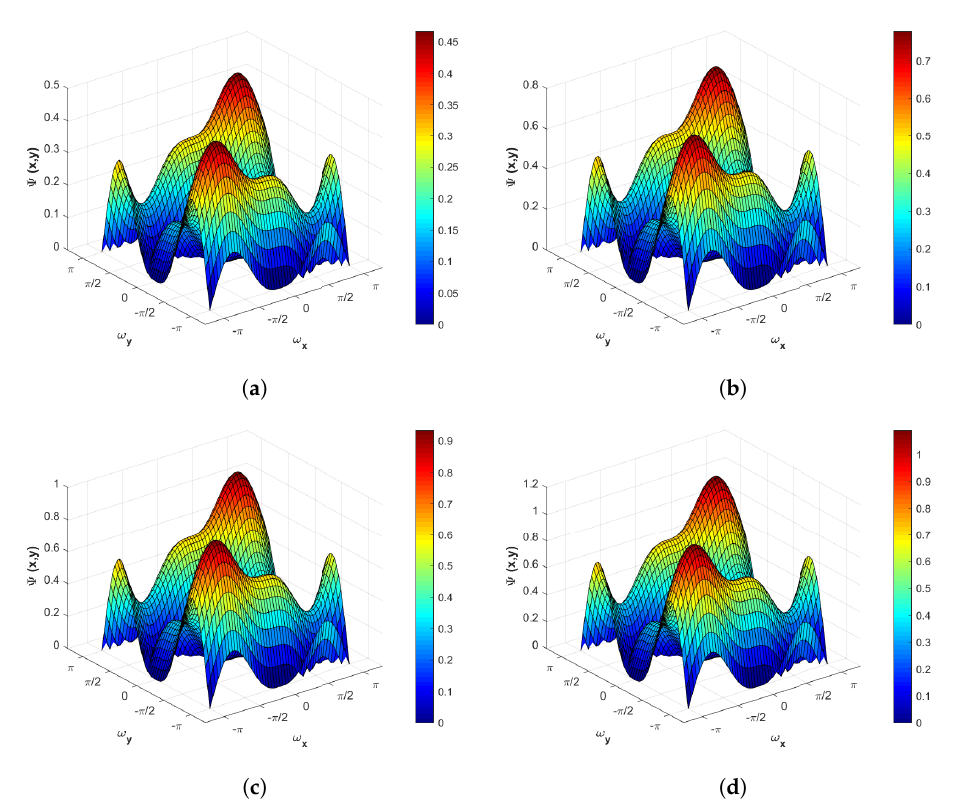
Figure 14. Plots of Ψ ( x , y ) vs. ω x vs. ω y for the ∆ t -values of ∆ t = 0.00008,0.0001,0.00012,0.00014. ( a ) ∆ t = 0.00006; ( b ) ∆ t = 0.00010; ( c ) ∆ t = 0.00012; ( d ) ∆ t =